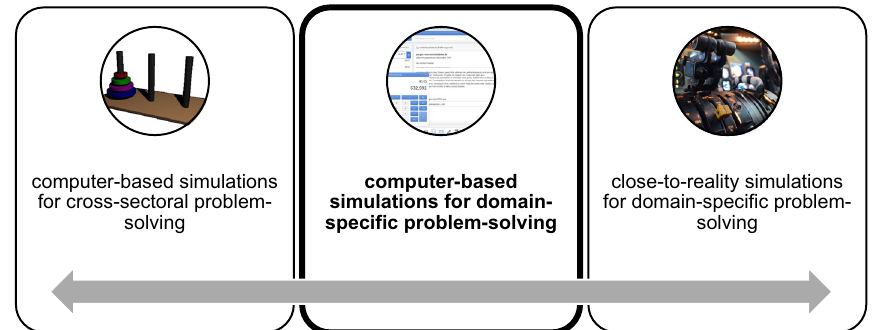
Fig. 1 The scope of this review (in bold) is illustrated within a continuum between cross-sectoral and domain-specific problem-solving simulations (pictures